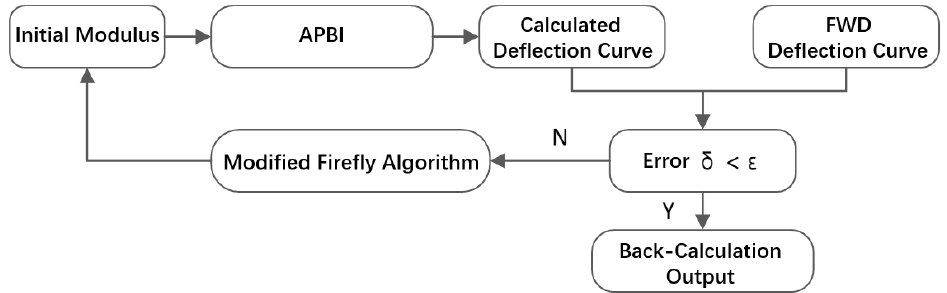
Figure 2. The Firefly Asphalt Back Calculation Method (FABCM)